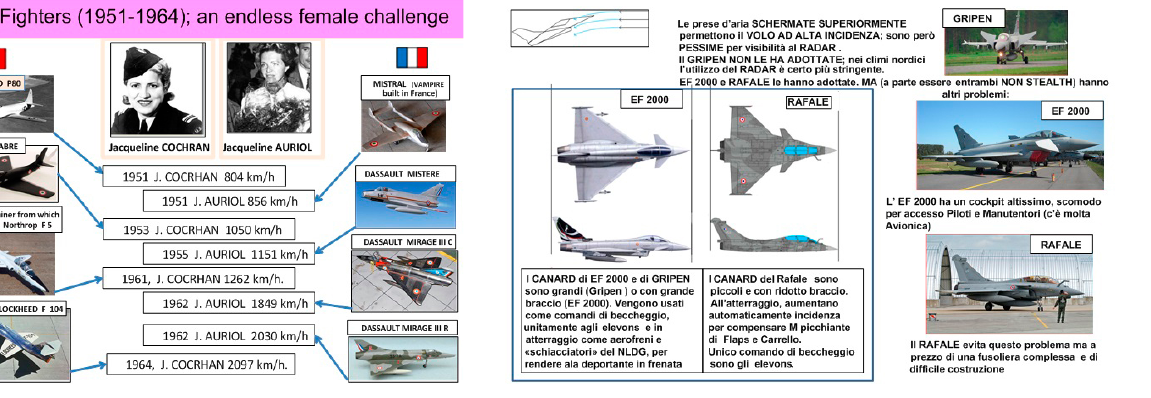
Fig. 8. Fighter speed evolution – Female Competition Fig. 9. Analysis of dissimilarities of EF 2000, Rafale, and Gripen